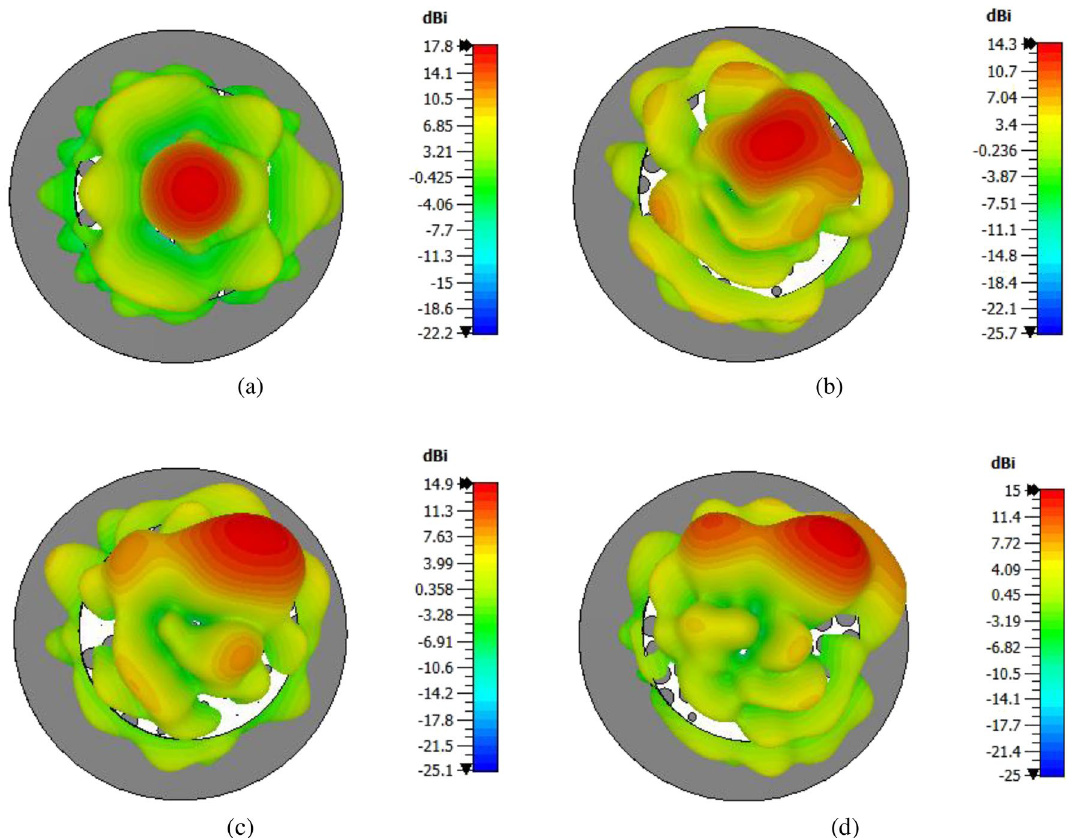
0 ◦ at all times and ψ 2 = 90 ◦ .